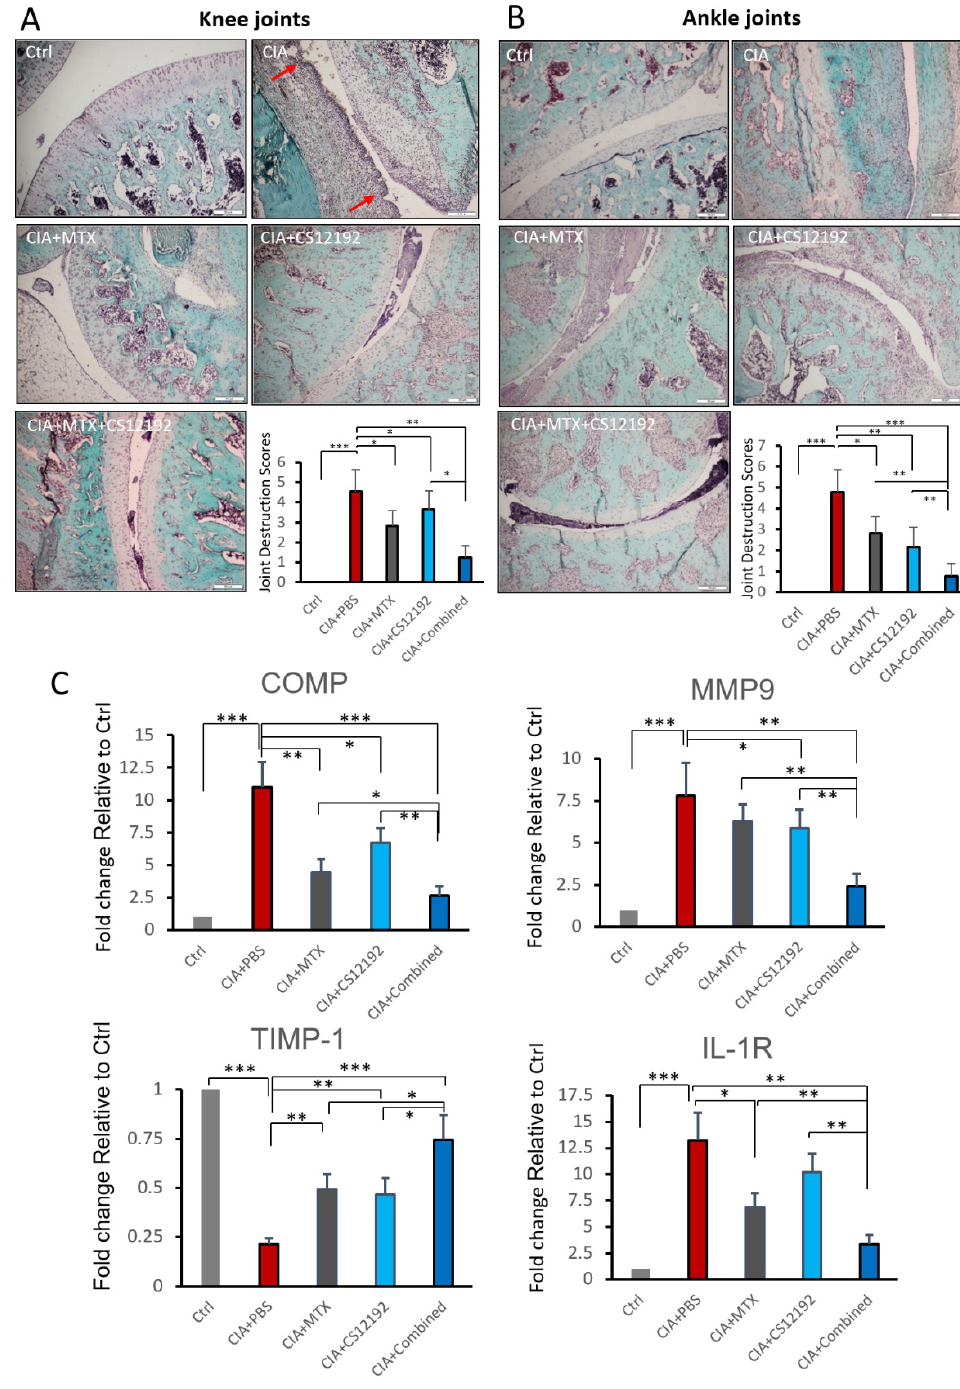
Figure 6. Effects of MTX, CS12192, or the combination of CS12192 and MTX treatments on cartilage destruction determined by safranin O-fast green staining and real-time PCR in joint tissues of CIA rats on day 28. ( A , B ) The safranin O-fast green staining joint tissue sections of knee (the red arrows are cartilage destruction areas) ( A ) and ankle ( B ). The cartilage destruction scores were measured as described in the Methods and are presented as the mean ±SEM from groups of 10 rats. Scale bar, 100 µM. ( C ) Real-time PCR analysis for relative mRNA expression of COMP, MMP-9, TIMP-1 and IL-1R in synovial tissues of CIA rats in response to different treatments. Results are presented as the mean ±SEM from groups of 10 rats. * p < 0.05; ** p < 0.01; and *** p < 0.001 as indicated.